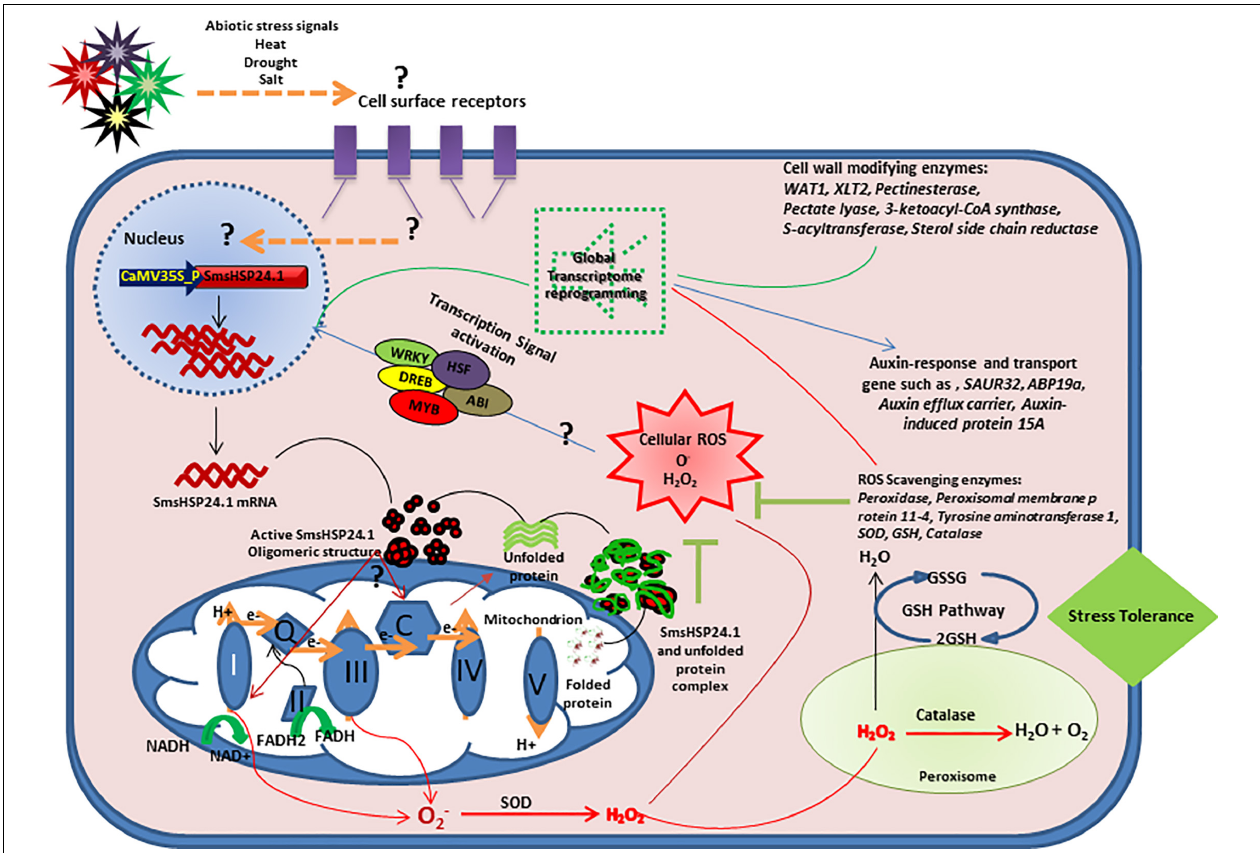
FIGURE 9 | Hypothetical model for understanding the molecular mechanism of SmsHSP24.1-mediated plant abiotic stress response. Overexpression of SmsHSP24.1 might interact with mitochondrial electron transport chain (ETC) which leads to increased ROS. A set of reactive oxygen species (ROS) scavenging enzymes of the glutathione (GHS) pathway also upregulated and maintains ROS below lethal dose which might act as a transcriptional activation signal of several stress-induced transcription factors and ultimately lead to change in global transcription.